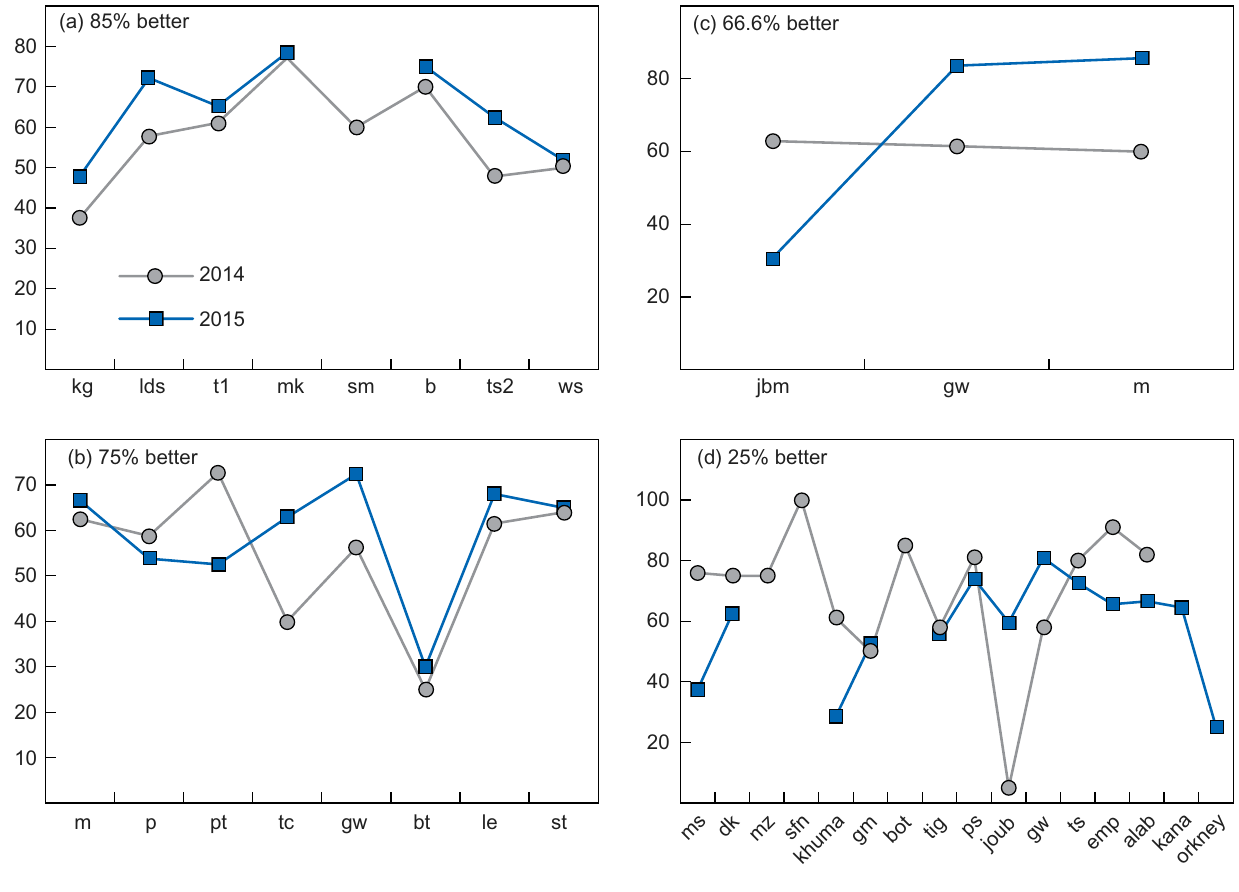
subdistricts.[All the abbreviations are abbreviated clinic names for anonymity] Figure 7: Comparisons between 2014 and 2015 suppressed VLs in four